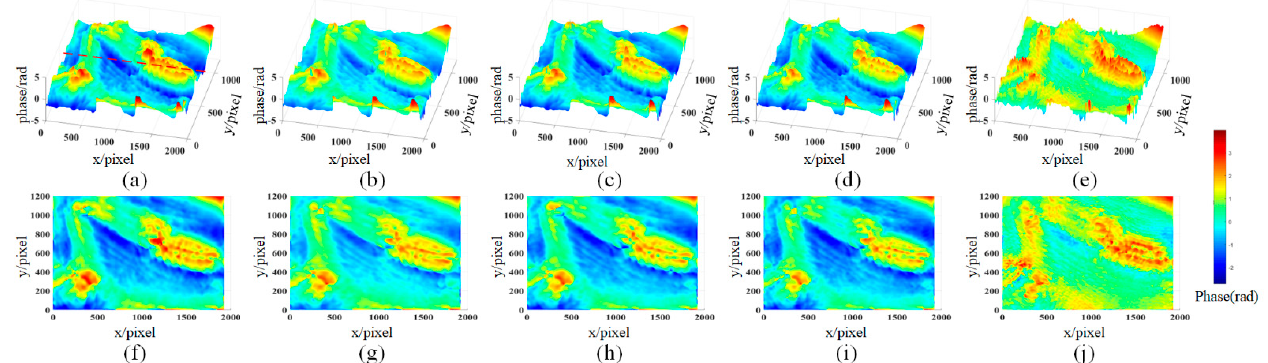
Figure 8. The reconstructed phase maps of honeybee foot interferogram. ( a – d ) The 3D display of the reconstructed phase maps after processing Figure 4d by the method proposed in this paper, the improved P-M equation method with Canny operator, the mean filter method and the median filter method, respectively. ( e ) The 3D display of the reconstructed phase map of Figure 4d without denoising. ( f – i ) The 2D display of the reconstructed phase maps after processing Figure 4d by the method proposed in this paper, the improved P-M equation method with Canny operator, the mean filter method and the median filter method, respectively. ( j ) The 2D display of the reconstructed phase map of Figure 4d without denoising.